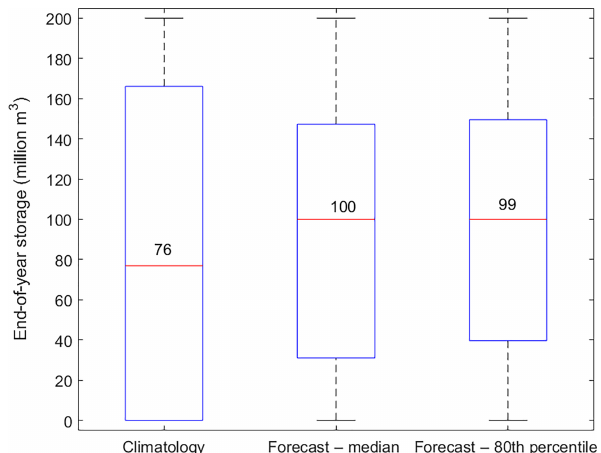
Figure 10. End-of-year reservoir storage under three allocation ap- proaches; 100Mm 3 is the